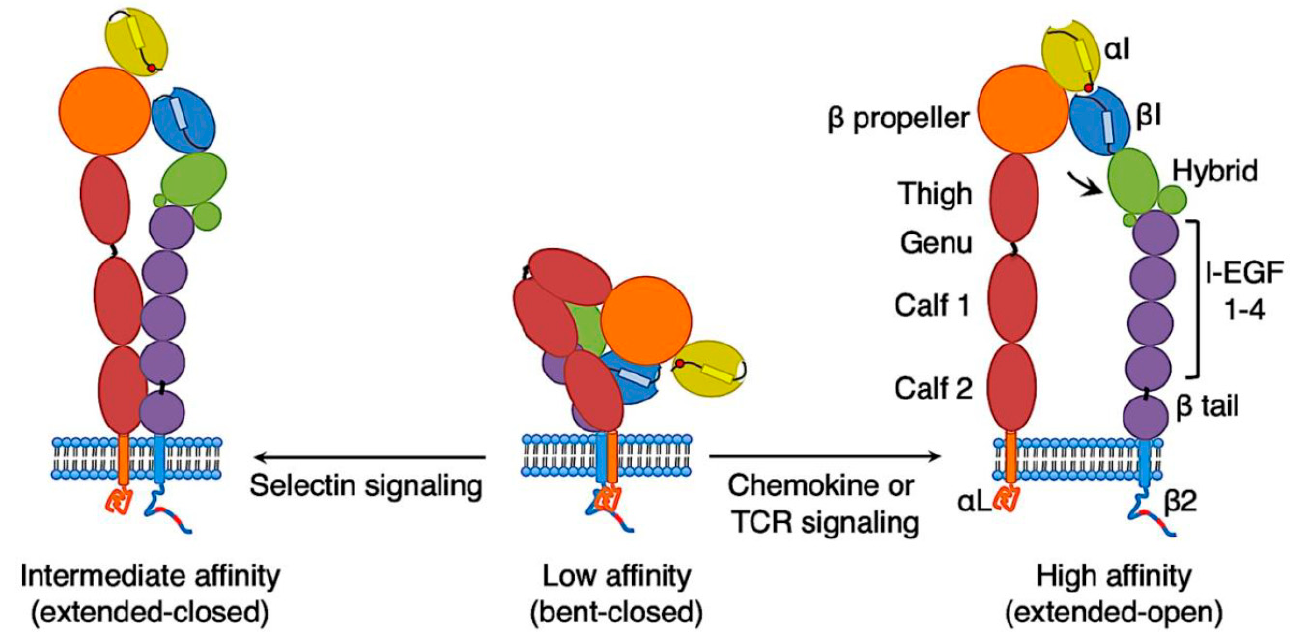
Figure 1. Distinct LFA-1 conformations and affinities in T cells. The low-affinity LFA-1 adopts the conformation of a bent ‘leg’ with a closed ‘head’. Inside-out activation of LFA-1 by signaling from T-cell receptor (TCR) or chemokines triggers its conformational change to a high-affinity state: an extended ‘leg’ with an open ‘head’. In contrast, selectin engagement leads to intermediate-affinity state LFA-1 in effector T cells: an extended ‘leg’ with a closed ‘head’. Structurally, the integrin ‘head’ can be opened when the hybrid domain swings away from the α L subunit. Interactions of the α 7 helix in the β I domain with the membrane proximal β tail domain bend the ‘leg’ at the ‘knee’, which locates at α L subunit genu and between I-EGF1 and I-EGF2 domains of the β 2 subunit. Movements in ‘head’ and ‘leg’ regions allow the extracellular domain of integrin LFA-1 to adopt at least three distinct conformations: bent ‘leg’ with a closed ‘head’ piece, extended ‘leg’ with a closed ‘head’ piece, and extended ‘leg’ with an open ‘head’ piece. Differing conformations of the LFA-1 extracellular domain correspond to distinct ligand-binding affinities. A closed and an open ‘head’ piece on the extended extracellular domain allow LFA-1 to bind its ligands with the intermediate and high affinities, respectively [5]. LFA-1 with a bent extracellular domain and a closed ‘head’ exhibits a low affinity for ligands [5]. Compared to the bent-close conformation, LFA-1 with the extended-open conformation has a 10,000-fold higher affinity for ligands [6]. In addition, β 2 integrins on neutrophils with a bent ‘leg’ can have an open ‘head’ and bind to intercellular adhesion molecule (ICAM)-1 or ICAM-3 with a high affinity through cis interactions [7]. However, neutrophils express several β 2 integrins, such as LFA-1 and Mac-1 ( α M β 2, CD18/CD11b); it is not clear whether LFA-1 can have an open ‘head’ on the bent ‘leg’. LFA-1 is the only β 2 integrin on T cells. LFA-1 on T cells can be presented with a bent ‘leg’ with a closed ‘head’ and an extended ‘leg’ with a closed or an open ‘head’ [8–11]. Beside three principal conformations, transitional conformations of integrin β 2 also